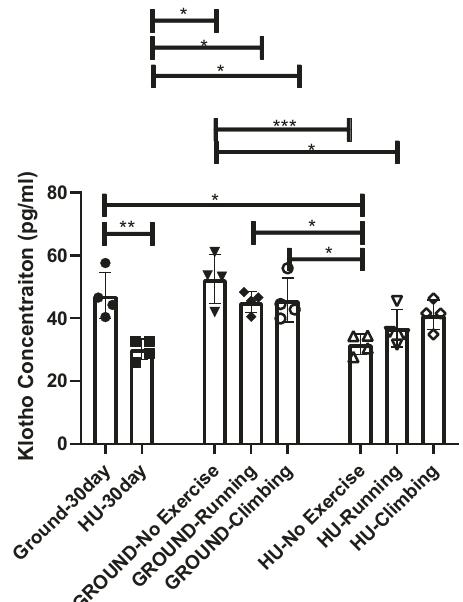
Fig. 2 α Klotho concentration is reduced after hind limb unload- ing, but can recover with subsequent exercise. α Klotho was lower than GROUND in plasma after 30 days HU, but recovery occurred with exercise * p ≤ 0.05; ** p < 0.01; *** p < 0.001 determined via Tukey ’ s Post Hoc test after performed after ANOVA. Bars: Mean(SD).